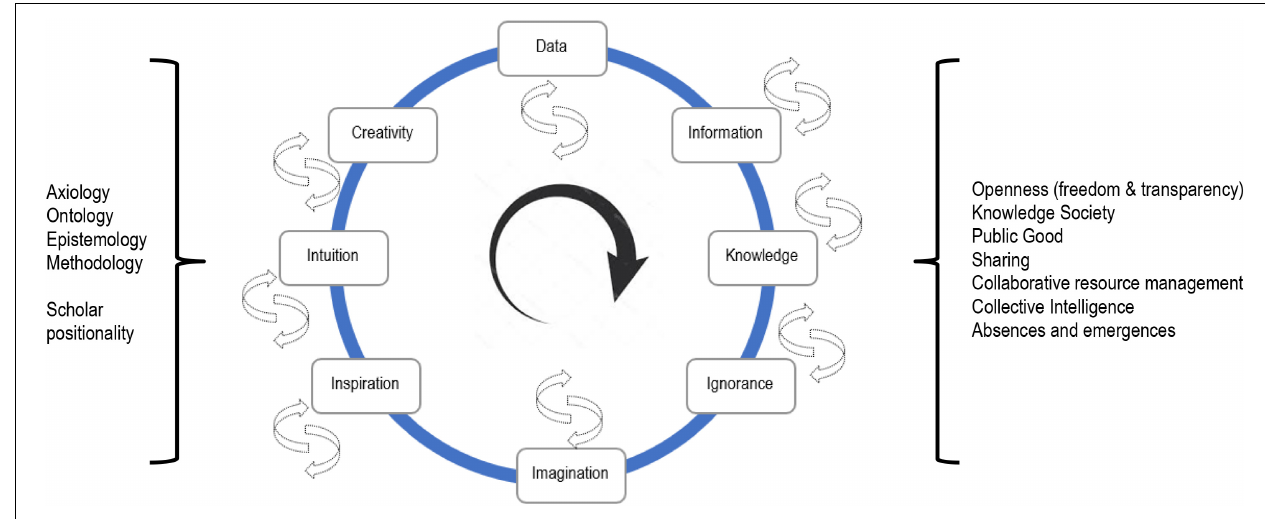
FIGURE 2 | Toward Openness in the knowledge creation process, building in ignorance, imagination, inspiration, intuition, and creativity.